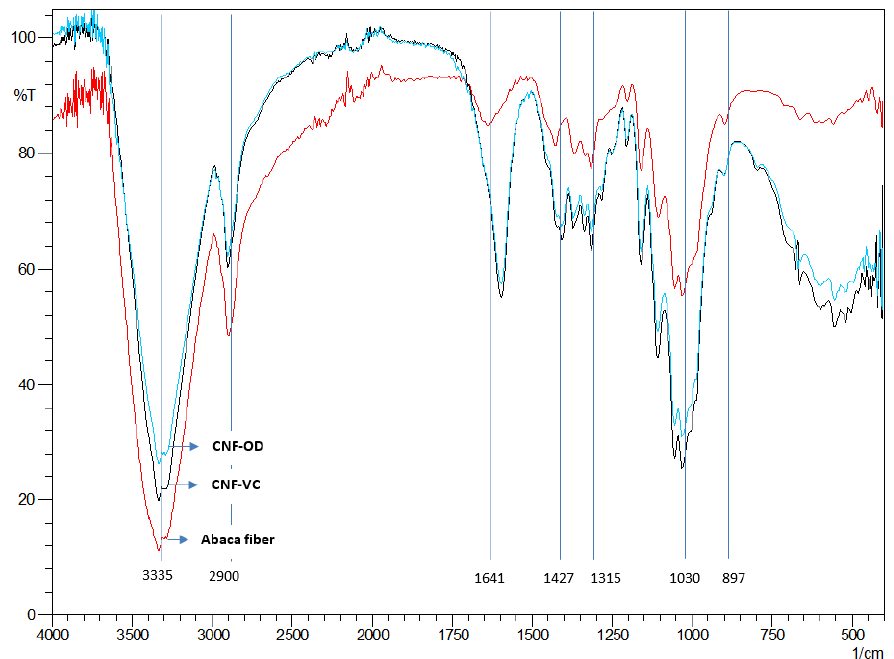
Figure 4. FTIR spectra of abaca fiber and CNF